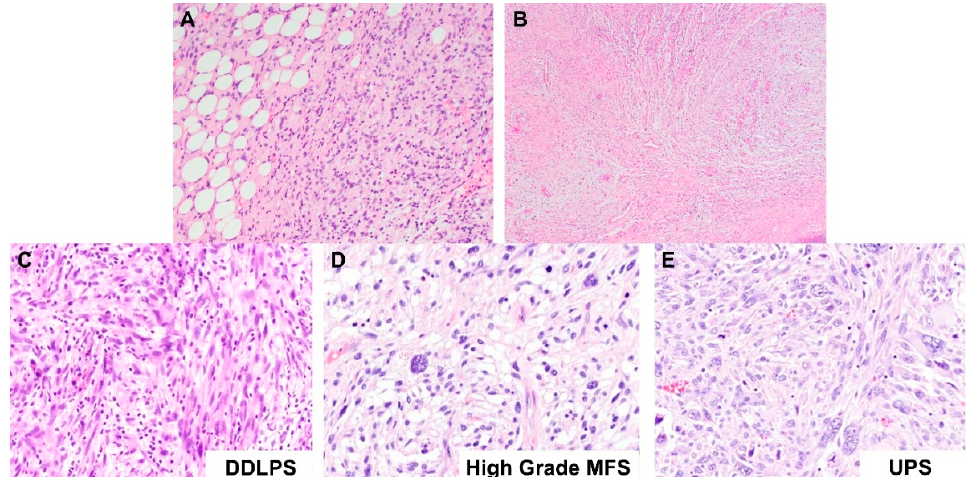
Figure 2. Histological comparison between dedifferentiated liposarcoma (DDLPS), myxofibrosarcoma (MFS) and undifferentiated pleomorphic sarcoma (UPS). ( A ) Microscopic image of a DDLPS (H&E stain, 100× magnification). The adjacent well-differentiated component is identified (left aspect), which serves as the diagnostic area for DDLPS. ( B ) Microscopic image of an MFS (H&E stain, 40× magnification). The image shows the myxoid low-grade area of MFS, characterized by curvilinear blood vessels, spindle cells, lobulated areas and myxoid stroma. This area serves as the diagnostic area for high-grade MFS. ( C – E ) Microscopic images showing side-by-side comparison of ( C ) DDLPS, ( D ) high-grade MFS and ( E ) UPS (H&E stain, 200× magnification). As illustrated here, the three pleomorphic sarcomas exhibit similar pleomorphic morphology, making the differential diagnosis of the three tumor subtypes difficult.